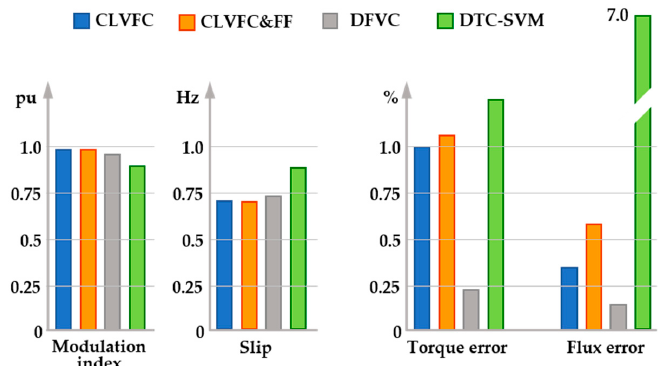
Figure 19. From left to right: modulation index, slip, torque error, and error in the flux being controlled for the four control methods being considered, once the machine has reached a steady state, i.e., is its maximum torque. Torque and slip have been low-pass filtered to eliminate the harmonic content produced by SHE